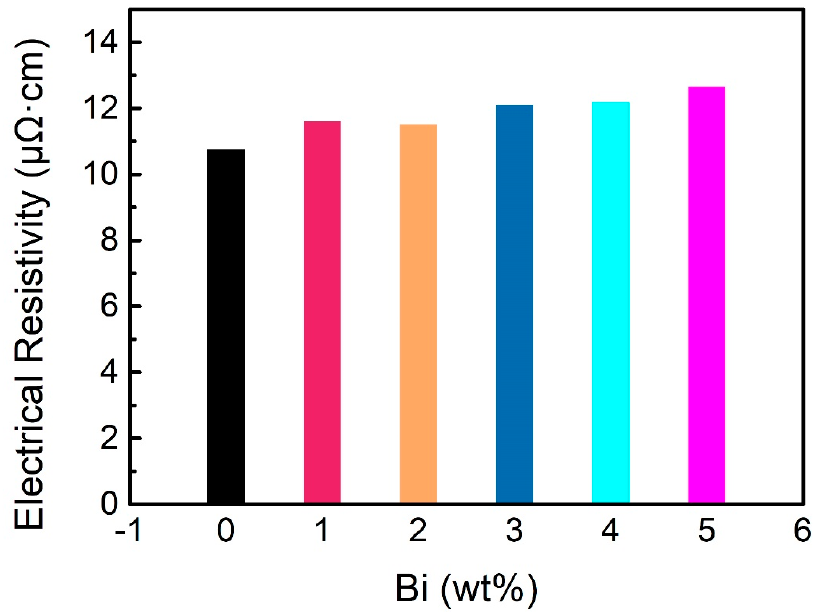
Figure 15. Electrical resistivity of the Sn-9Zn-xBi solder